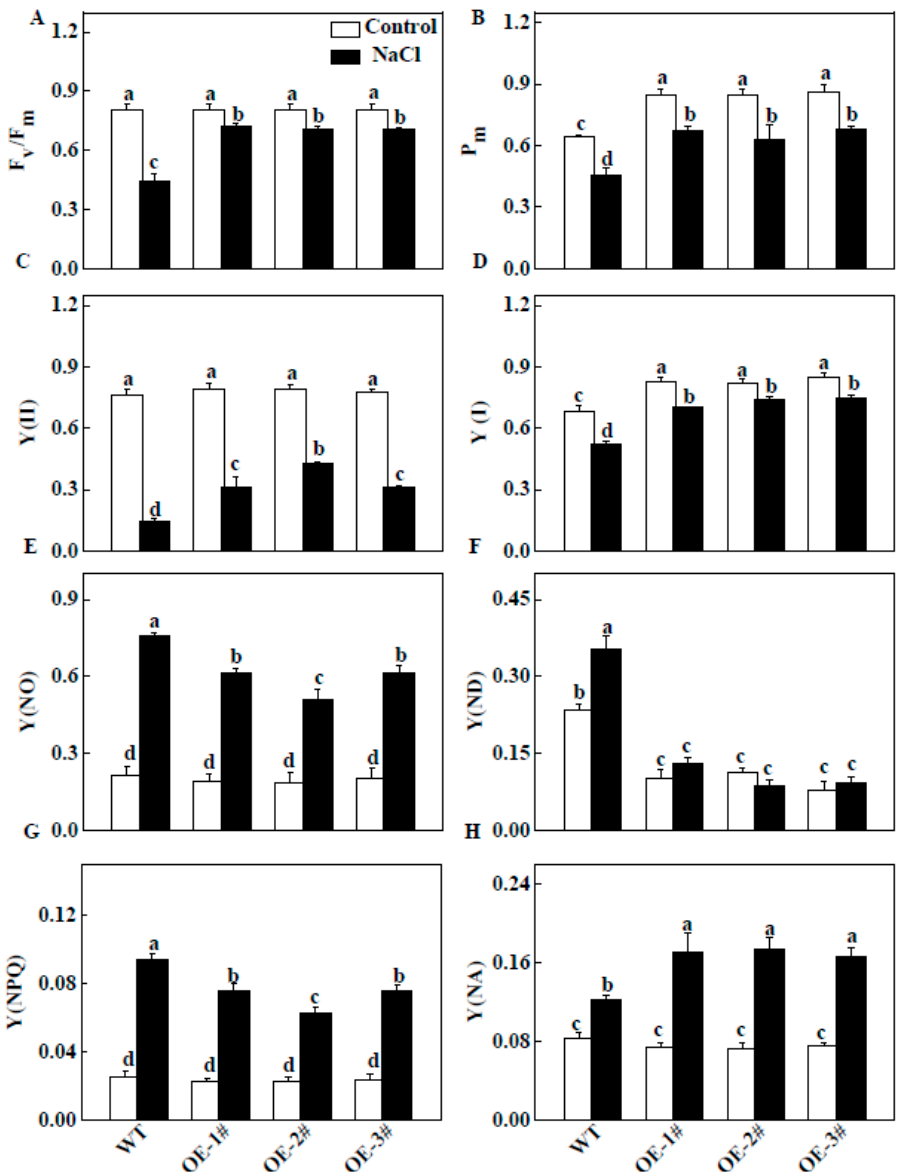
Figure 9. Changes in PSII and PSI in leaves of WT and CsTGase OE plants under salt stress. ( A ) The maximal quantum efficiency of PSII (F v /F m ). ( B ) The maximum fluorescence of PSI (P m ). ( C ) The effective quantum efficiency of PSII (Y(II)). ( D ) The effective quantum efficiency of PSI (Y(I)). ( E ) The nonregulated energy dissipation (Y(NO)). ( F ) The oxidation status of PSI donor side (Y(ND)). ( G ) The regulated energy dissipation (Y(NPQ)). ( H ) The reduction status of PSI accept or side (Y(NA)). Each histogram represents a mean ± SE of four independent experiments ( n = 4). Different letters indicate significant differences between treatments ( p < 0.05) according to Duncan’s multiple range test.